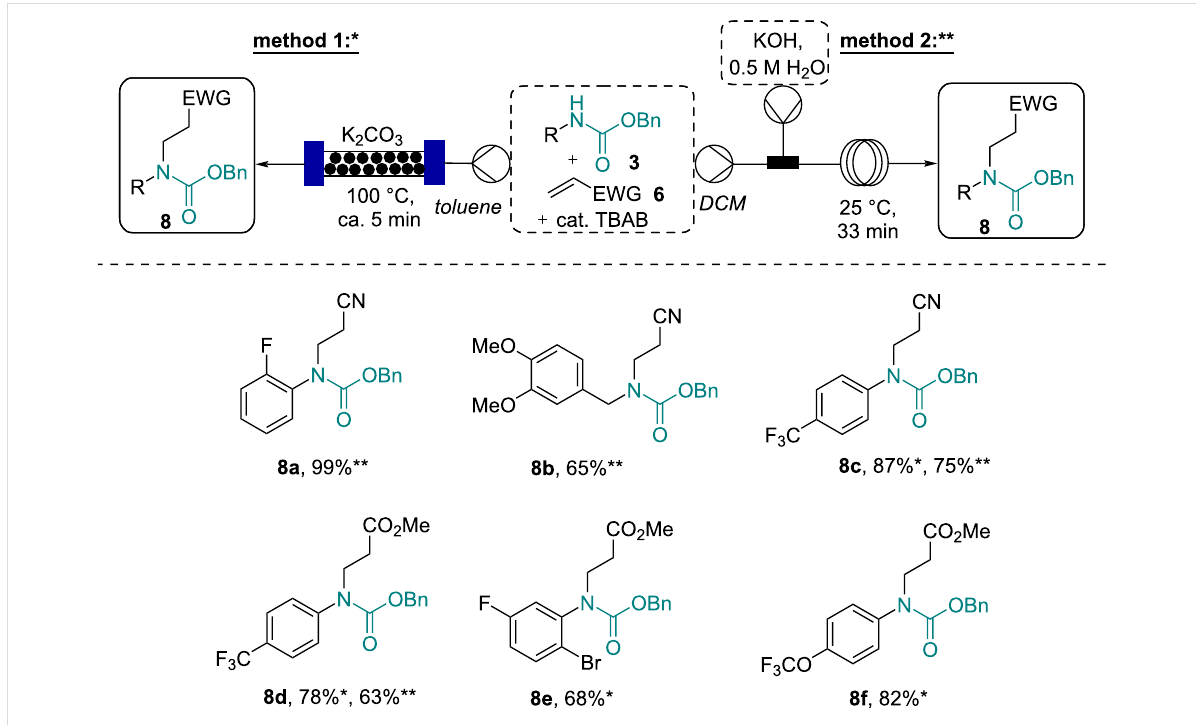
Scheme 5: Complementary flow approaches towards the β -amino acid derivatives 8